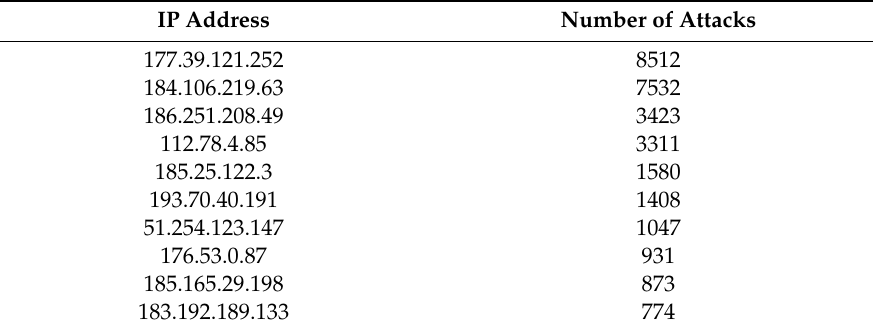
Table 3. The IPs of attackers with the number of